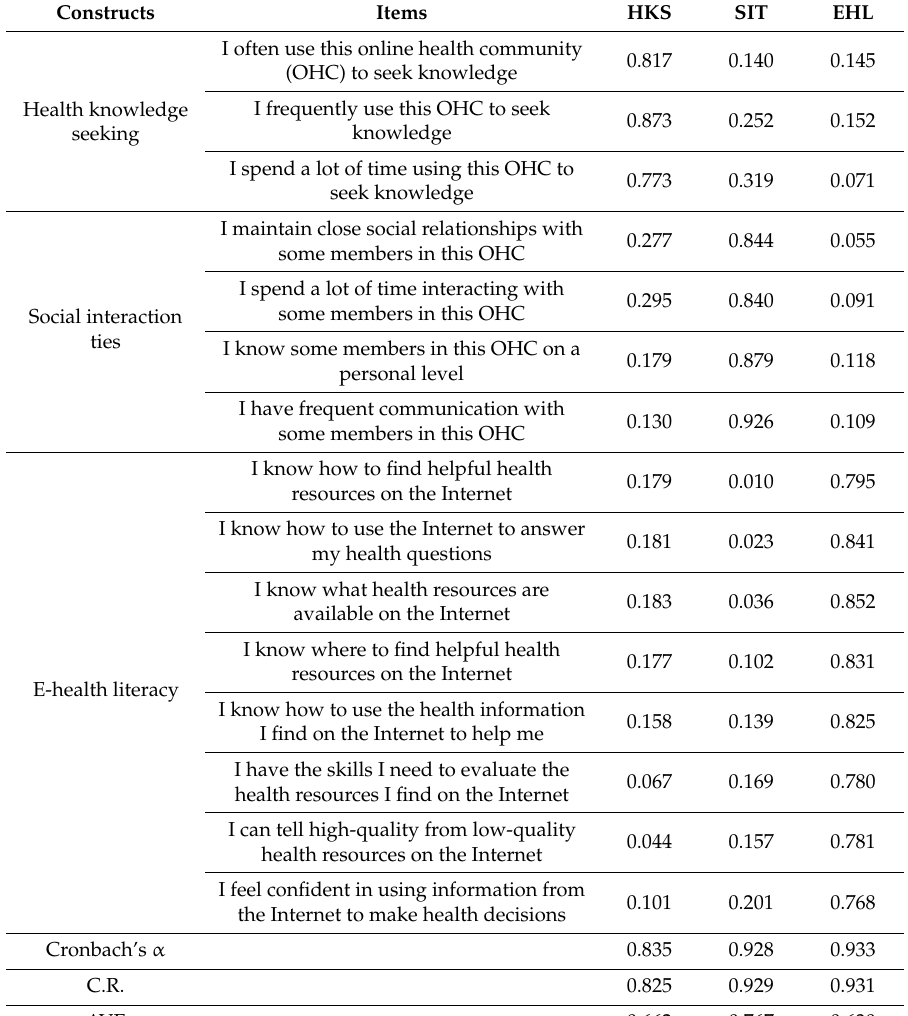
Table 3. Items and Factor Loadings.